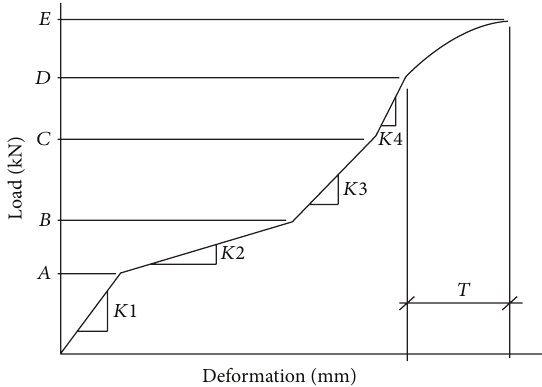
Figure 3: Ungkurapinan et al. lap-splice bolted joint model [18].